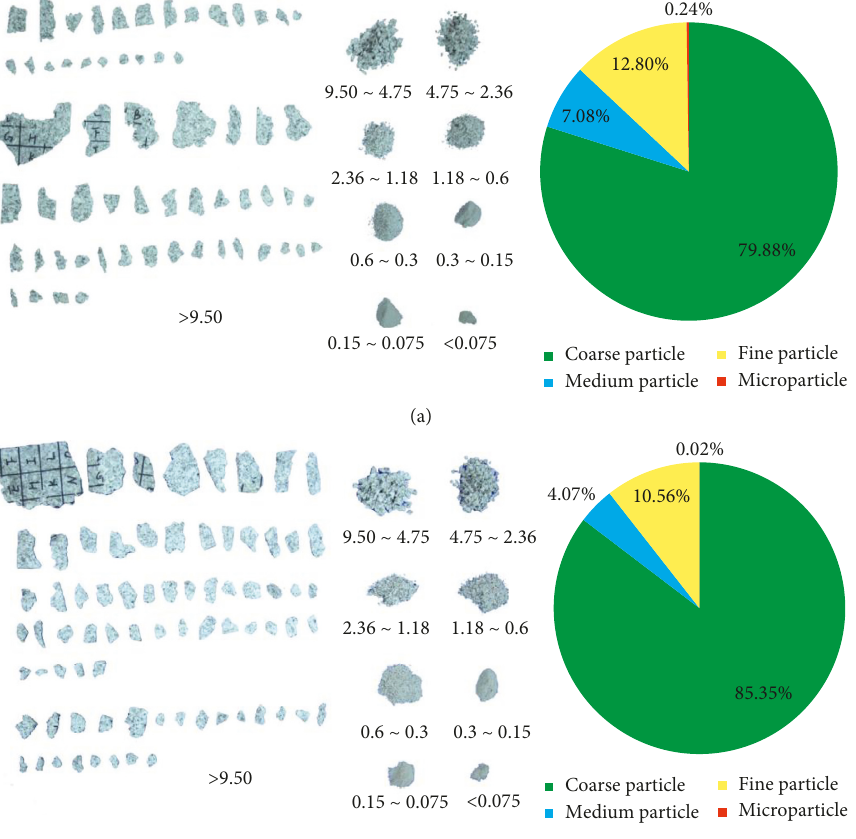
Figure 10: The failure form of the tested specimens under different support forces: (a) σ